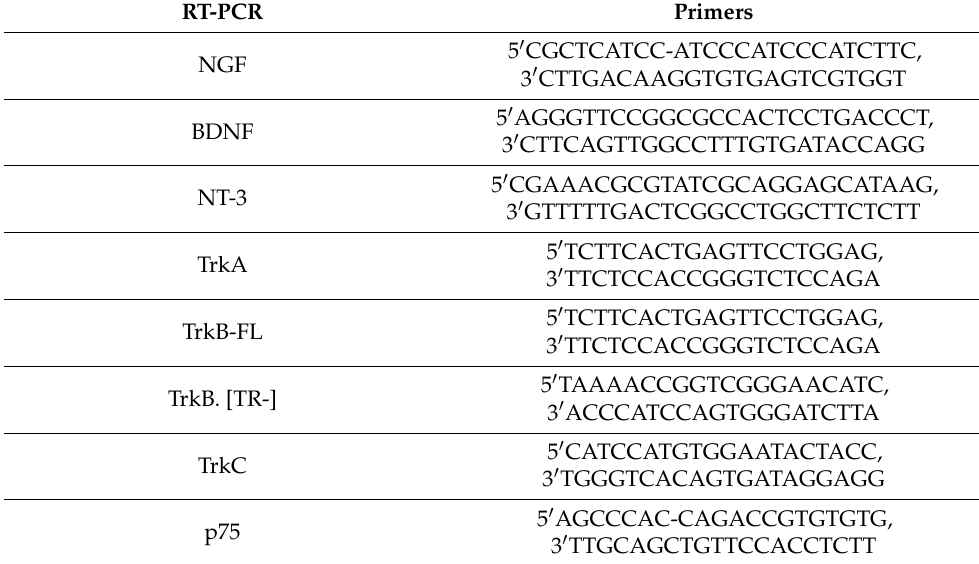
Table 2. Primers used in RT-PCR [19].